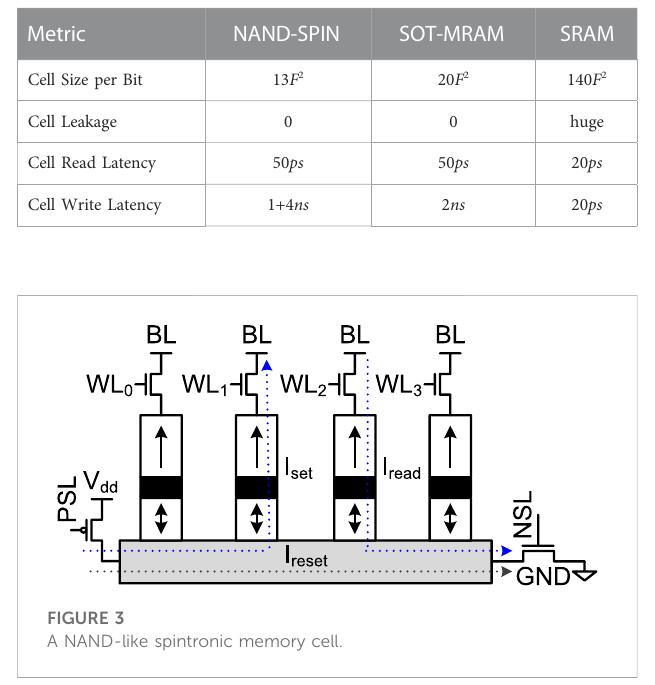
FIGURE 3 A NAND-like spintronic memory